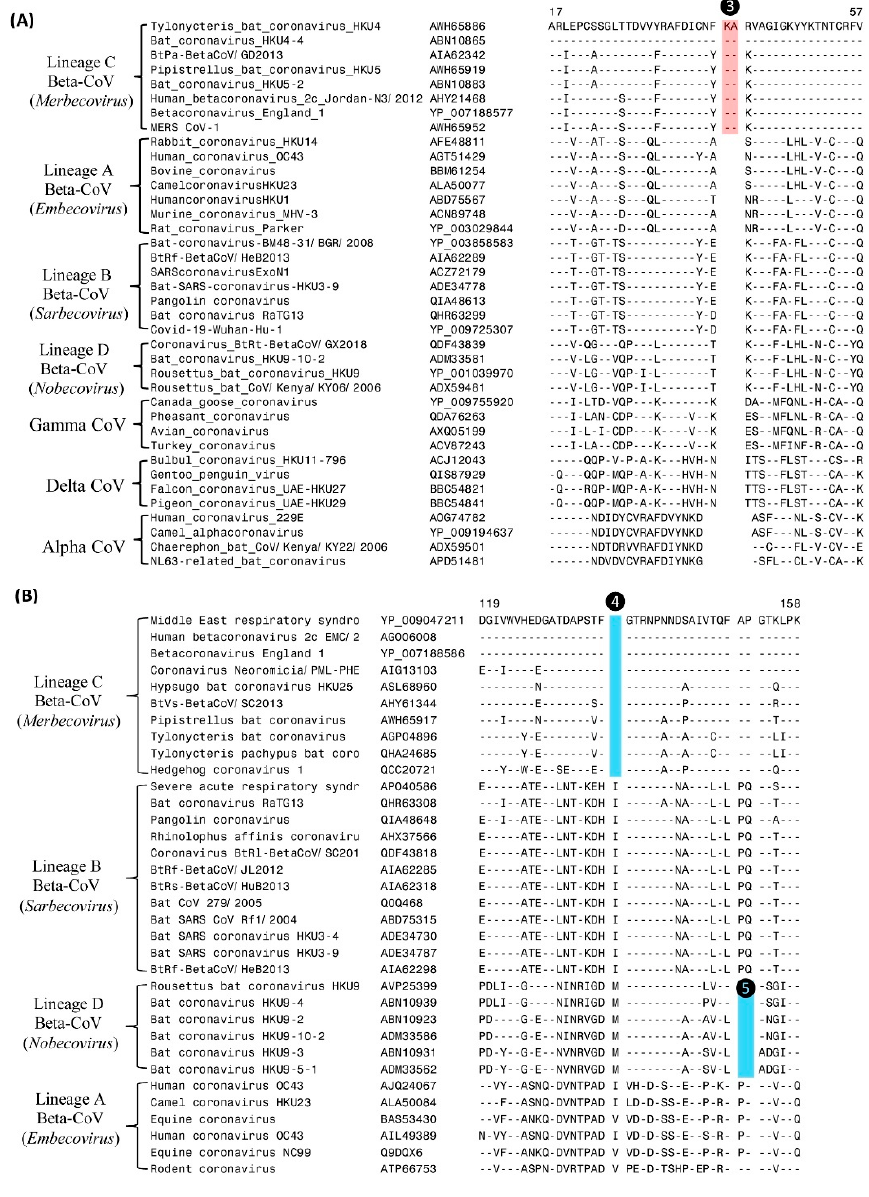
Figure 3. Partial sequence alignments of two conserved regions from the RdRp and nucleocapsid proteins showing a number of CSIs that are specific for the subgenera Merbecovirus and Nobecovirus . ( A ) Partial sequence alignment of RdRp protein showing a CSI consisting of 2-aa insertion (highlighted in blue and labeled ❸ ) which is specific for the Merbecovirus . ( B ) Partial sequence alignment of nucleocapsid protein showing two different CSIs, one of which ( ❹ ) is specific for the subgenus Merbecovirus and another CSI (labeled ❺ ), which is only present in different viruses from the subgenus Nobecovirus .